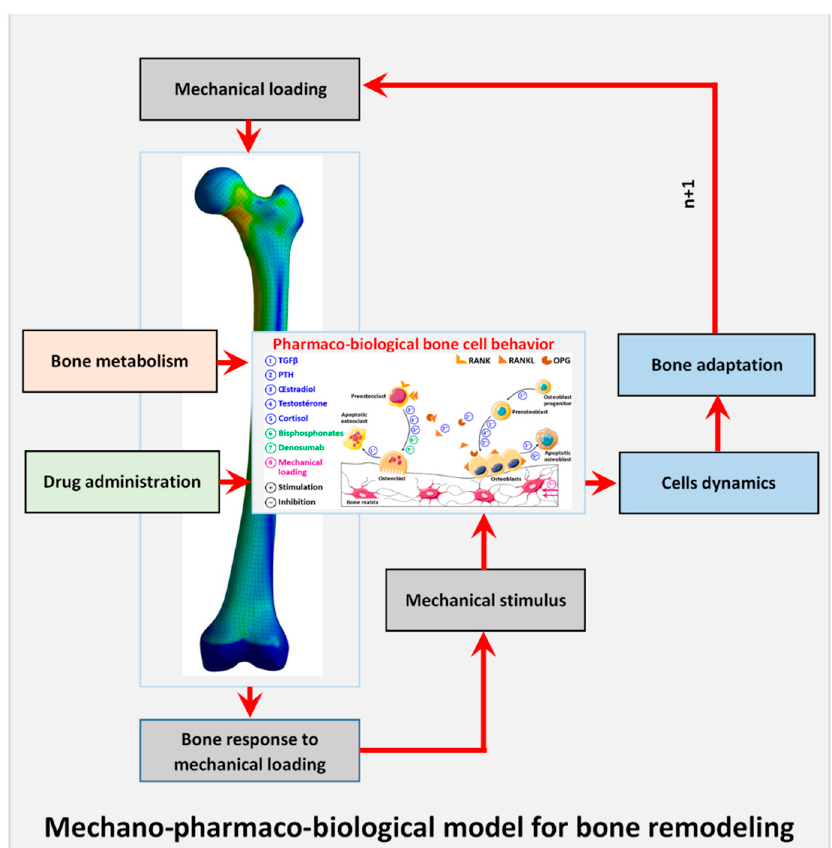
Figure 4. Diagram summarizing the proposed mechano-pharmaco-biological